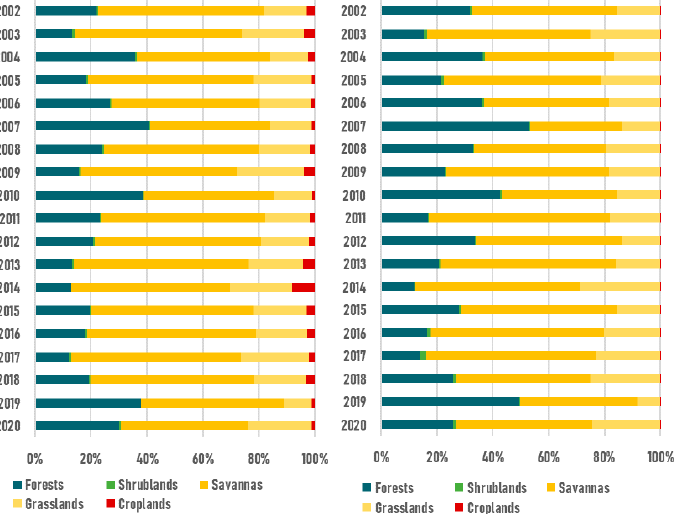
Figure 9. Percentage of annual fire impact by land cover types in the period 2002–2020, in Bolivia ( left ) and the KBAs ( right ).